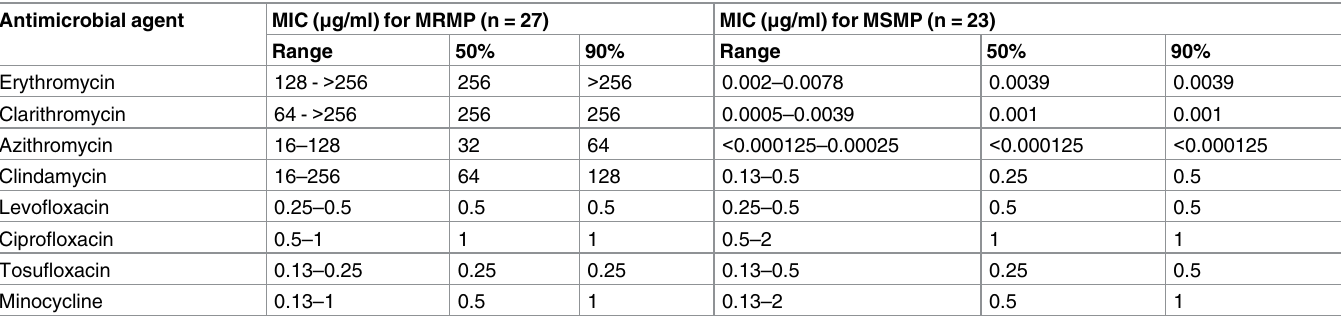
Table 2. In vitro anti-mycoplasma activities against clinical isolates of M . pneumoniae with or without A2063G mutation in the 23S rRNA gene. Antimicrobial